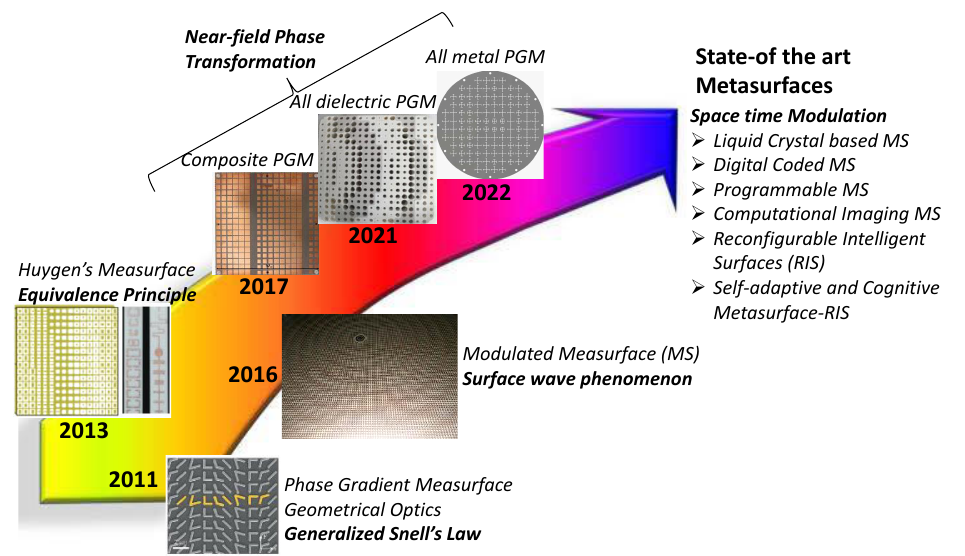
Figure 1. Evolution of metasurfaces over the last decade and some state-of-the-art metasurface technlogogies. The source for metasurface figures are as follows: 2011 [20], 2013 [9], 2016 [28], 2017 [29], 2021 [30] and 2022